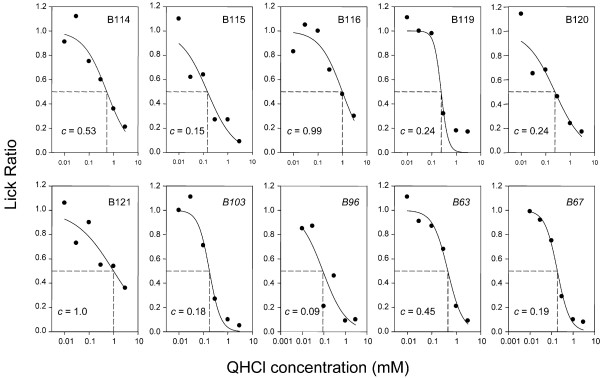
Concentration-response functions quinine in 10 individual B6 mice. Data points for each mouse represent average ratios across two days of testing; these means were fitted with two-parameter logistic functions and the concentration evoking half-maximal avoidance, c, was estimated. Italicized mice (B103, B96, B93, B67) were given QHCl as the last of three stimuli, as opposed to the others, which received QHCl as the first stimulus.